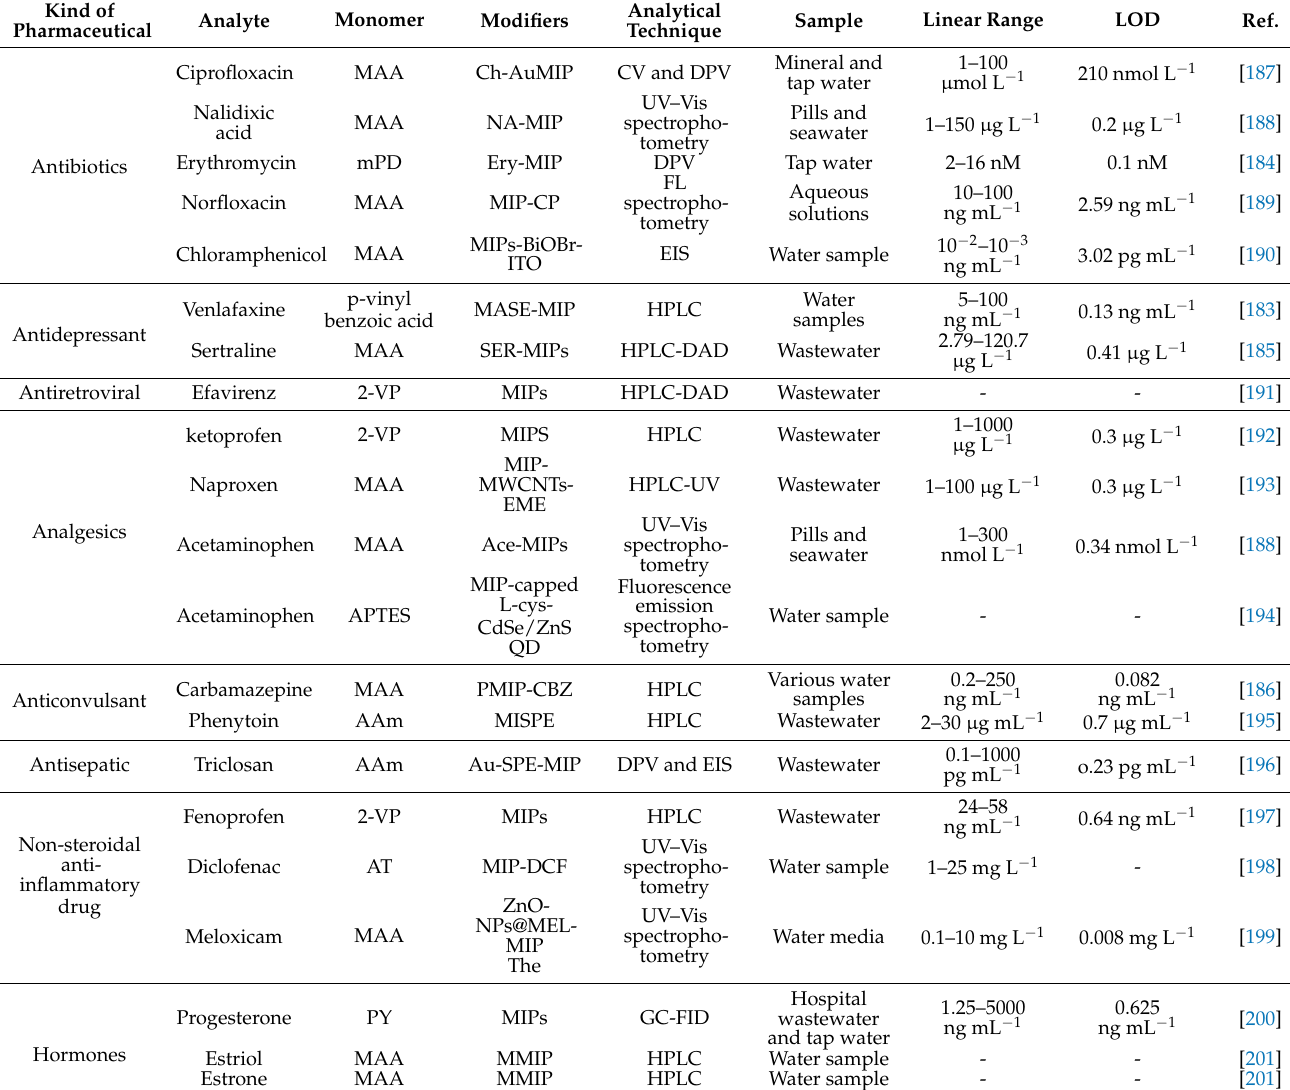
Table 5. Application of MIPs in the determination of pharmaceutical residues in waters and